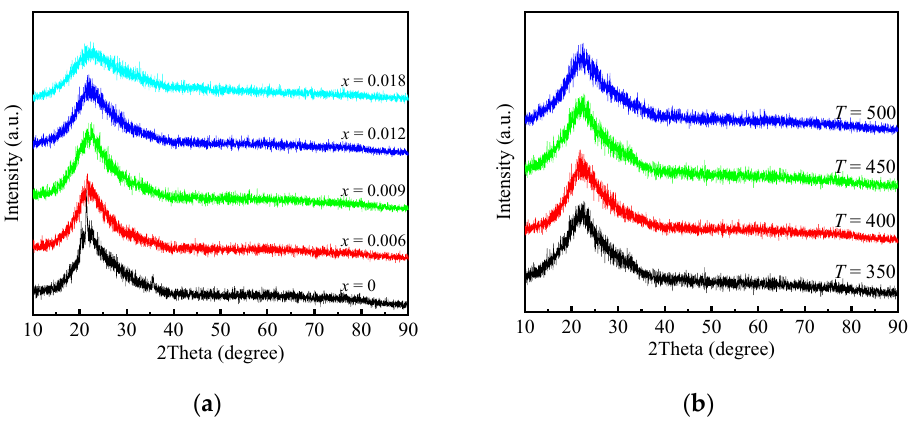
Figure 1. XRD patterns of the ( a ) AlP 1.1 Zr x -400 and ( b ) AlP 1.1 Zr 0.012 - T samples.